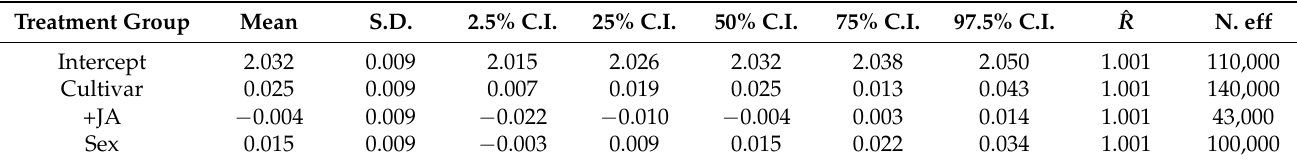
Figure 3. Estimate of S. frugiperda pupal mass ( y -axis, back-transformed to linear) across different treatment groups ( x -axis). Final pupal mass was only influenced by the cultivar. Estimates in the figure are displayed as violin plots, represented as a traditional boxplot overlayed on a kernel density plot of the distribution of the Bayesian posterior estimates. Table 3. Bayesian GLM with main effects model of S. frugiperda pupal mass across different G. max cultivars, innate/induced jasmonic acid plant defenses, and individuals’ gender. Note that the 95% Credible Intervals (C.I.) for innate/induced jasmonic acid plant defenses and sex overlap zero.